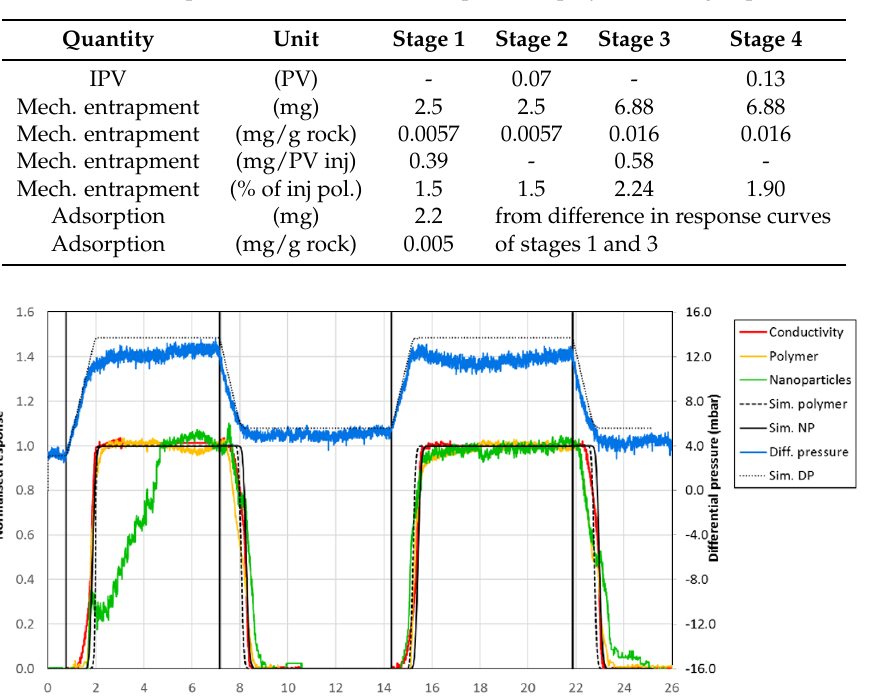
Table 10. IPV, adsorption, and mechanical entrapment of polymer during Experiment 3.